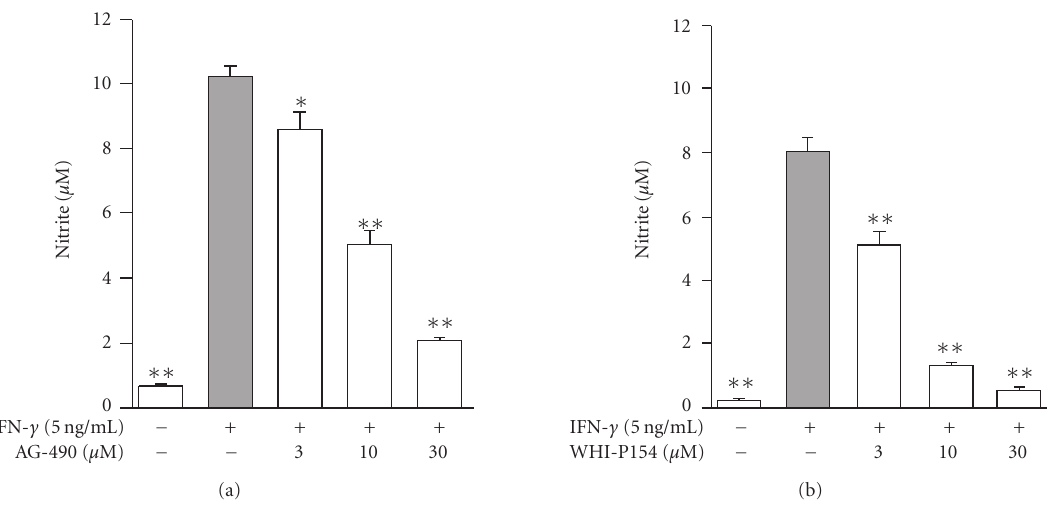
Figure 3: E ff ects of (a) AG-490 and (b) WHI-P154 on IFN- γ -induced nitric oxide (NO) generation in J774 macrophages. After 24-hour incubation with IFN- γ (5ng/mL), the supernatants were collected and nitrite was measured in the culture medium as an indicator of NO production by Griess reaction. The values are mean ± SEM ( n = 6), ∗ P < . 05, and ∗∗ P < . 01 when compared to cells treated with IFN- γ